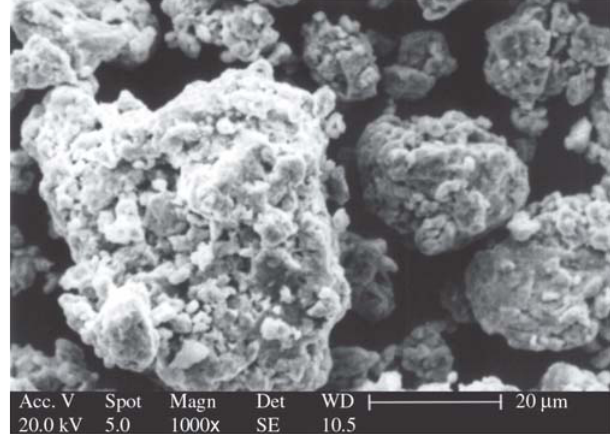
Figure 4. X-ray diffractogram of Cu-13Al-2Nb alloy quenched in ice water from 850 °C.